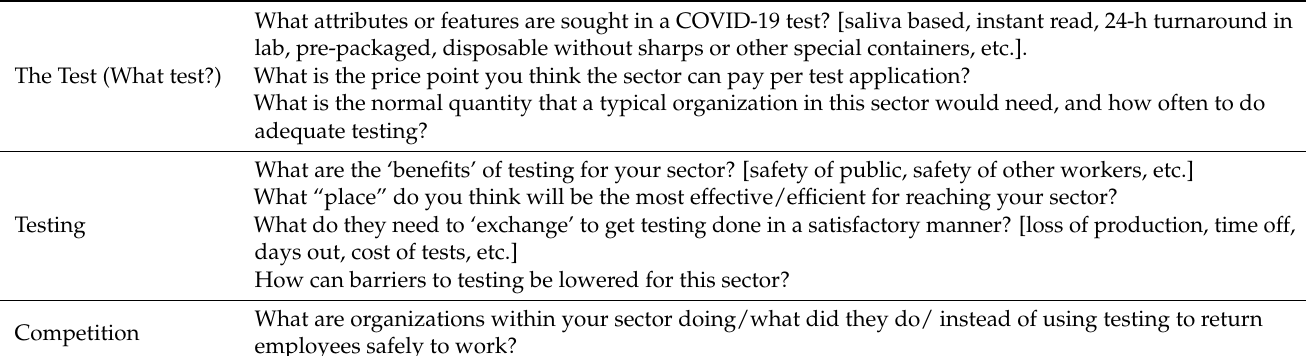
Table 1. Questions Asked to Develop Value